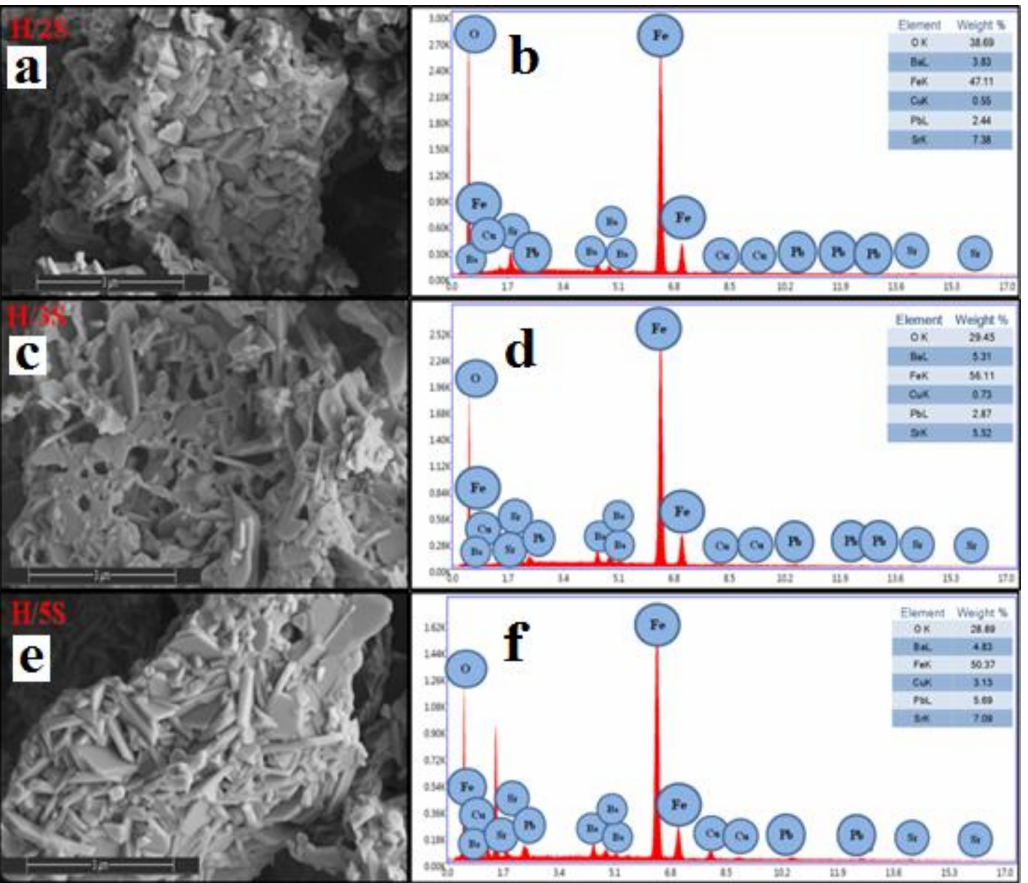
Figure 2. SEM images (a, c, e) and EDX spectra (b, d, f) of S r0.3 Ba 0.4 Pb 0.3 Fe 12 O 19 /(CuFe 2 O 4 ) x composite samples x = 2 ( a , b ), 3 ( c , d ) and 5 ( e , f ).